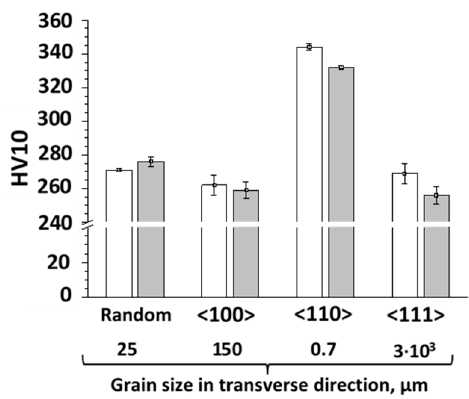
Table 3. Means and standard deviations of Vickers hardness (HV10) and Knoop hardness numbers, on transverse and longitudinal cross sections of Fe20Cr4.5Al alloy in different conditions.